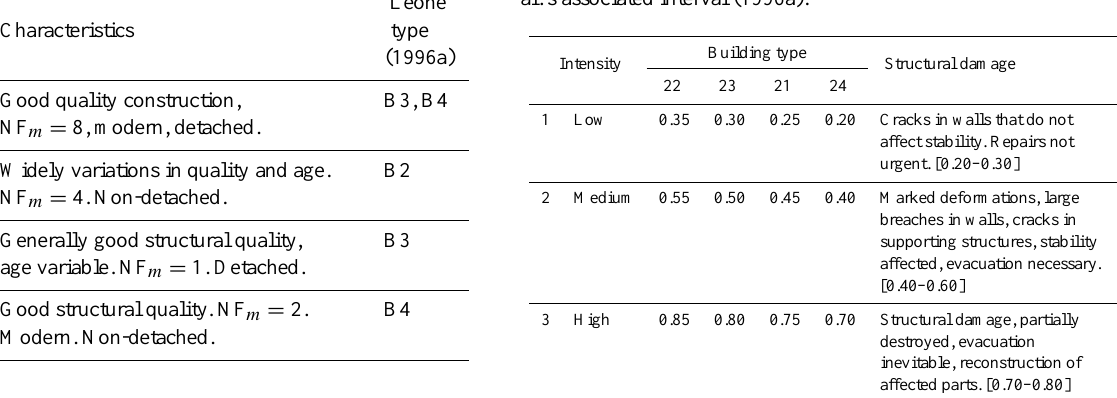
Table 9. Assessment of vulnerability according to type of building and landslide intensity. Damage estimates according to Leone et al.’s associated interval Leone